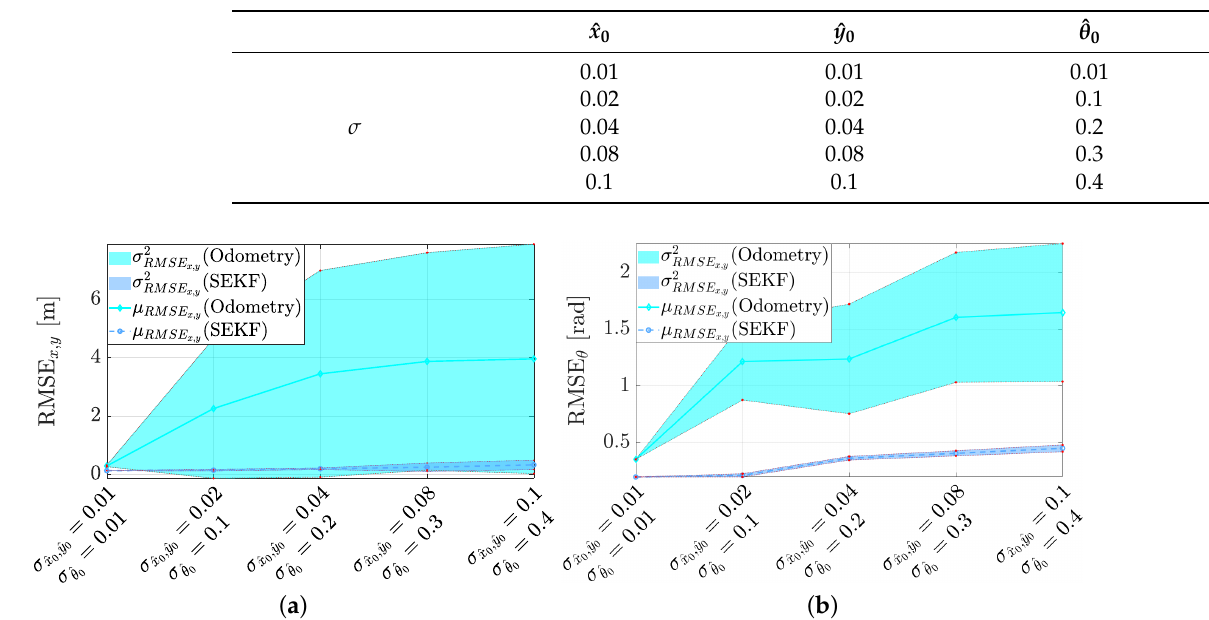
Table 1. Standard deviations assumed for the initial robot state and distributed according to a Gaussian probability density function.